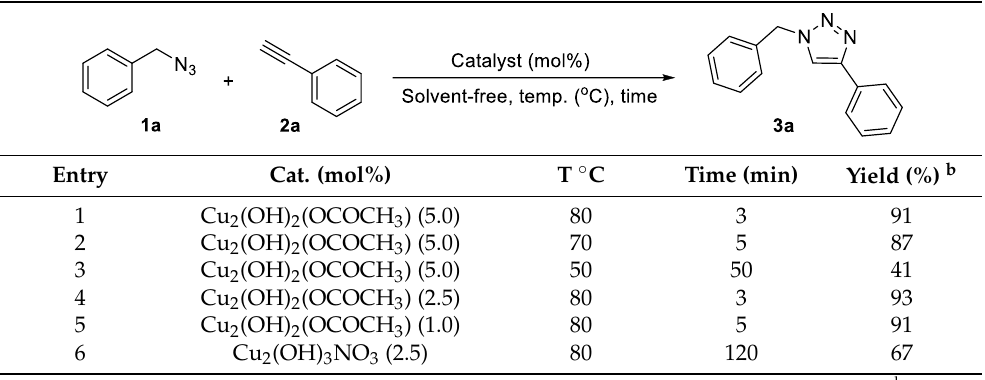
Table 3. Optimization of standard reaction parameters a .